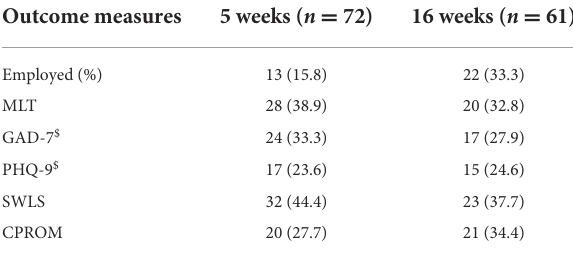
TABLE 3 Proportion who improved from baseline at 5 weeks and 16